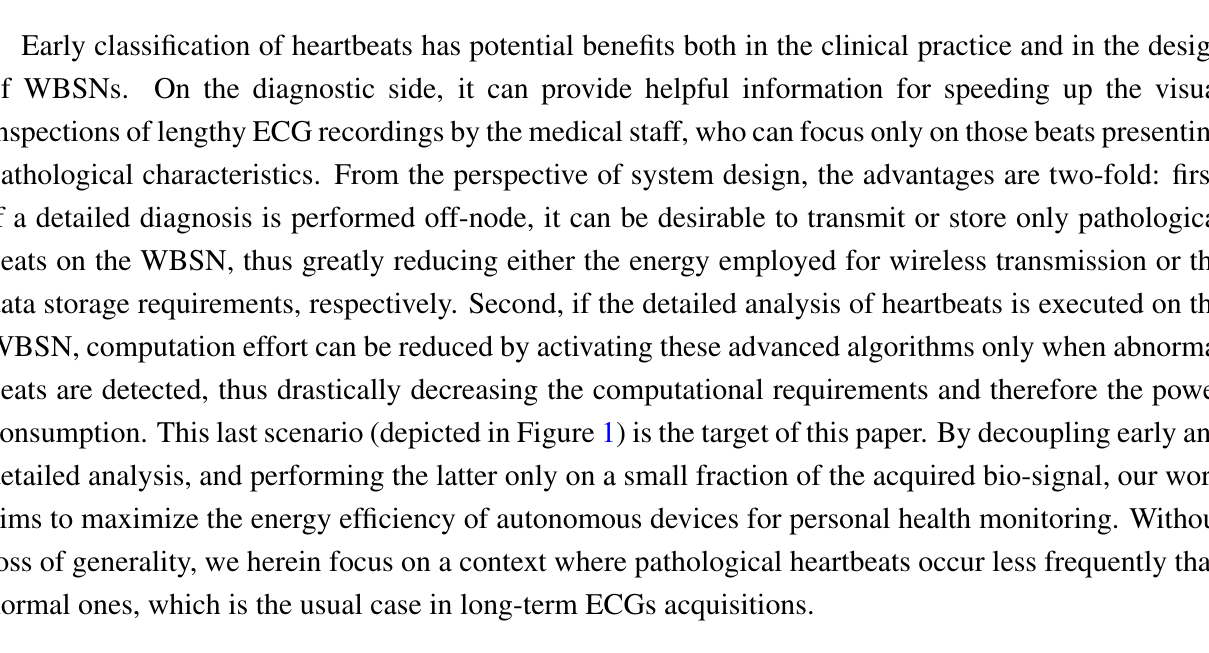
Figure 1. Target system featuring a classification block that selectively activates a detailed digital signal processing